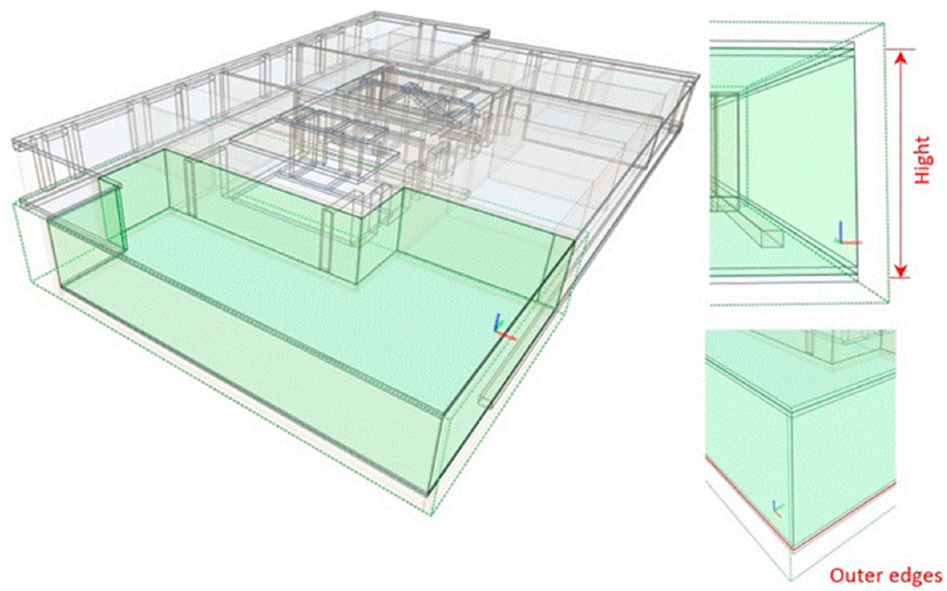
Figure 9. Representation of the IfcBuildingPropertyUnit.